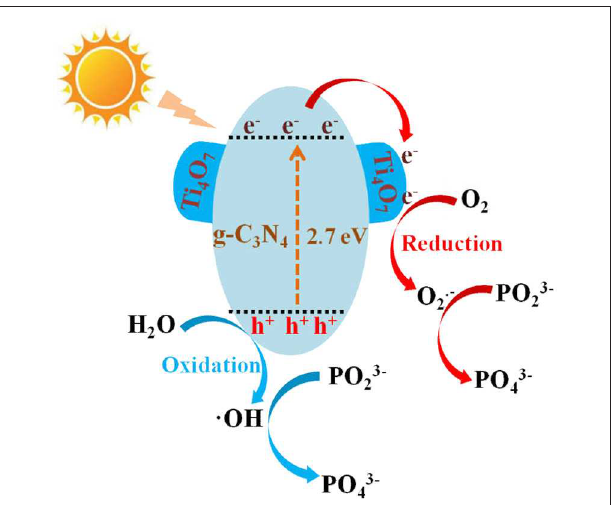
FIGURE 9 | The mechanism of the hypophosphite oxidation over the Ti 4 O 7 /g-C 3 N 4 photocatalyst under visible light